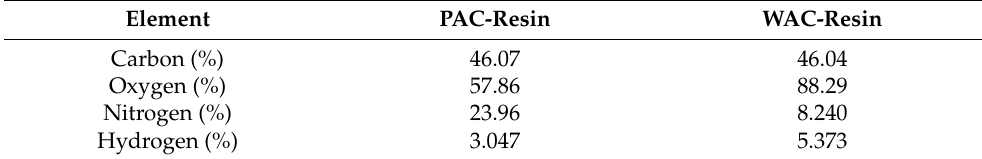
Table 1. Elemental compositions of the PAC-resin and WAC-resin measured by element analyzer. Element PAC-Resin Carbon (%)